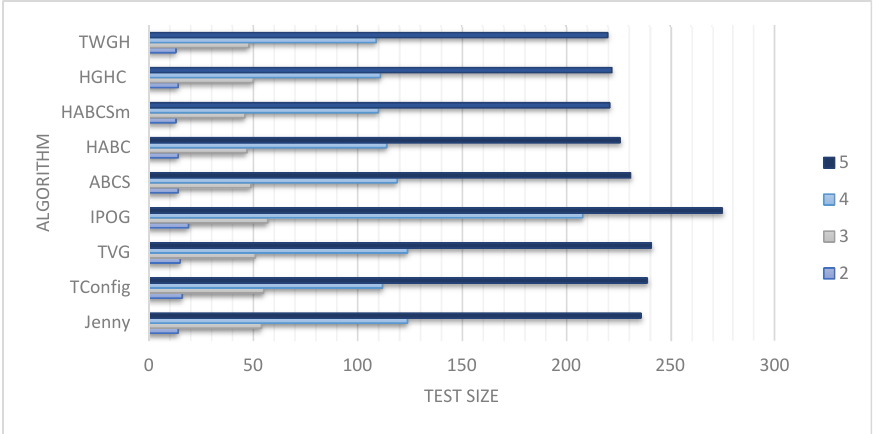
Figure 3. Test set size for CA (N; t, v 7 ) with t=3 and 2 ≤ v ≤ 5.